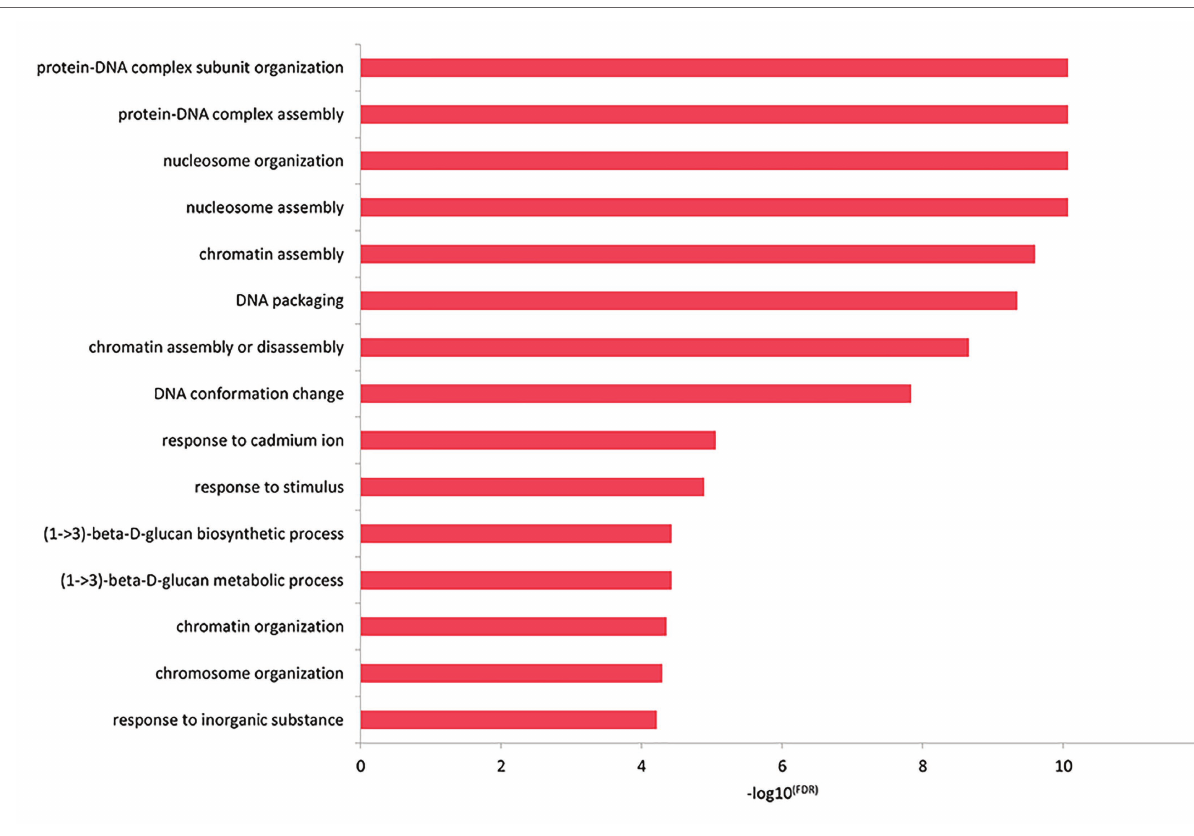
FIGURE 3 | The functional enrichment of the differentially expressed genes in the top GO biological